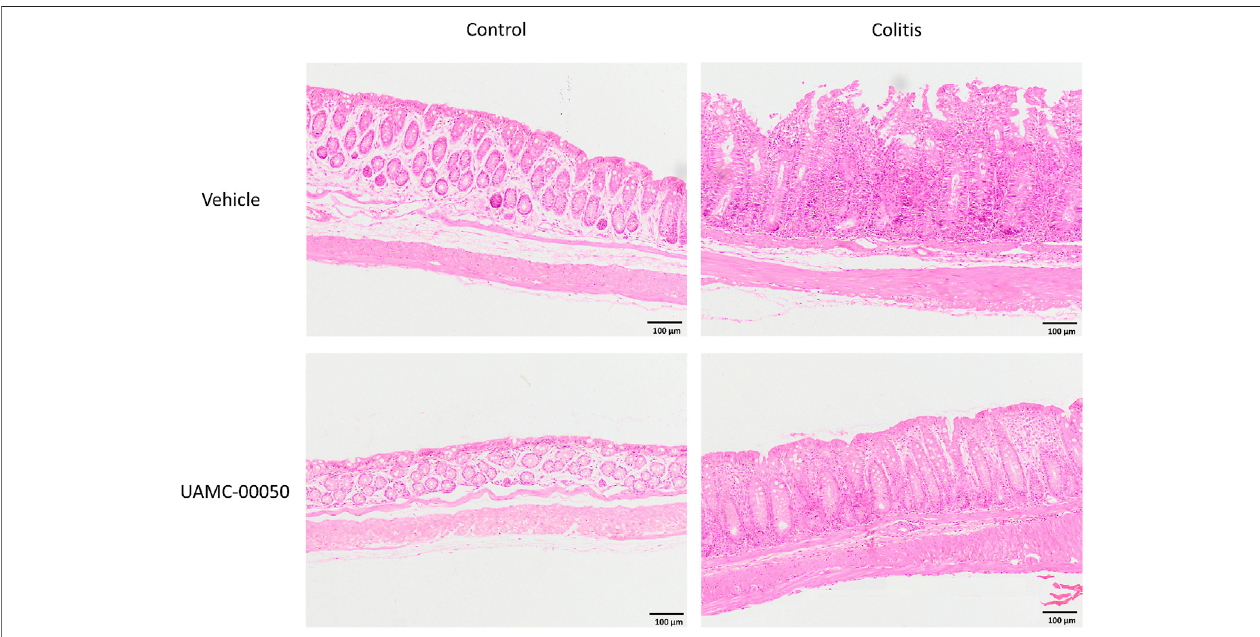
FIGURE 3 | Effect of curative treatment with UAMC-00050 on H&E stained colon sections in experimental colitis. Representative images of H&E stained colon sections (objective × 10, scale bar (cid:2) 100 µm) from the four different experimental groups (control + vehicle, control + UAMC-00050, colitis + vehicle, colitis + UAMC- 00050) that were microscopically scored in Figure 2E .